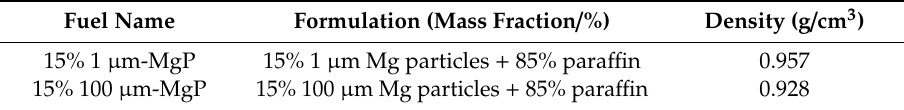
Table 8. Composition of the tested magnesium particles / para ffi n composite